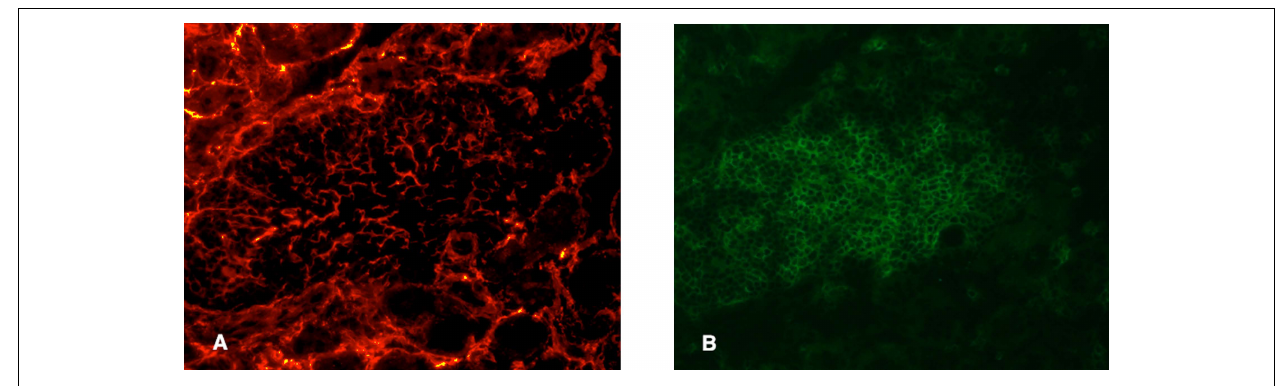
FIGURE 2 | Presumptive conduit in a RIPLT α TLO. Infiltrate of a RIPLT α mouse with a kidney infiltrate, stained with ER-TR7 (red; A ) anti-CD3 (green; B ). Note the presence of the fine network of ER-TR7 + cells underlying the